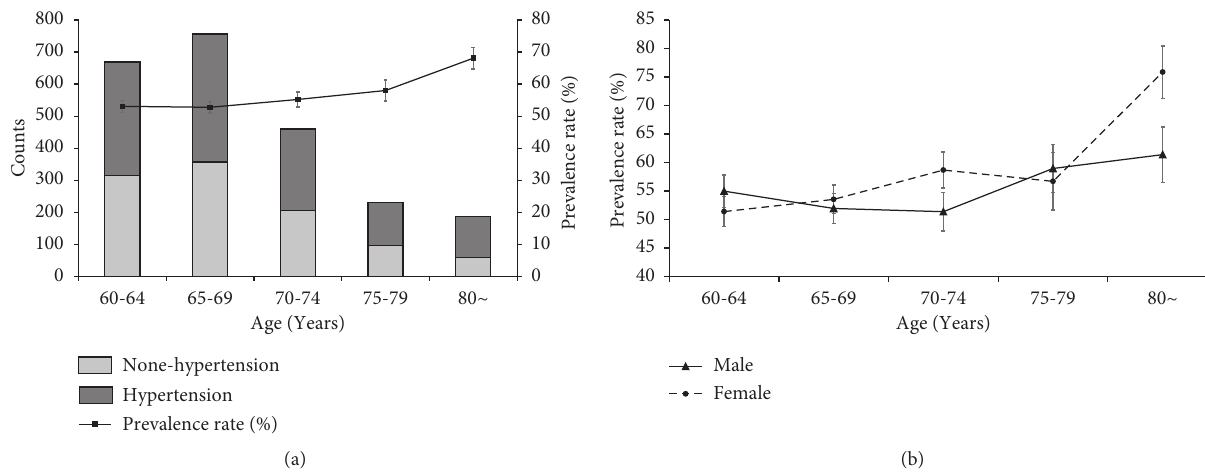
Figure 2: Prevalence of hypertension in a rural population without awareness of hypertension. (a) Prevalence of hypertension in different age groups. (b) Prevalence of hypertension in different gender and age groups. Table 1: The related factors of hypertension in the population without awareness of hypertension in a rural area over 60 years old. Normal Prehypertension Level 1 Level 2 Level 3 Statistics P Trend P